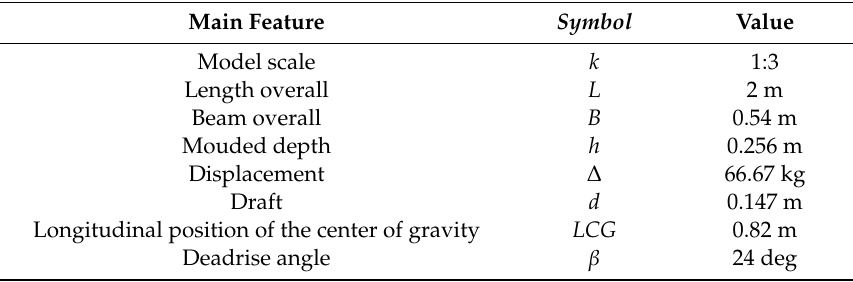
Figure 15. Threedimensional (3D) model and line plan of the improved vessel. Table 9. Model parameters of the improved